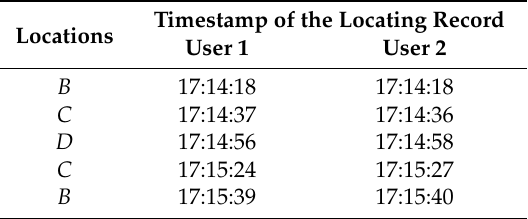
Table 2. Locating results of two simultaneous users recorded in the Cloud Database. Timestamp of the Locating Record Locations User